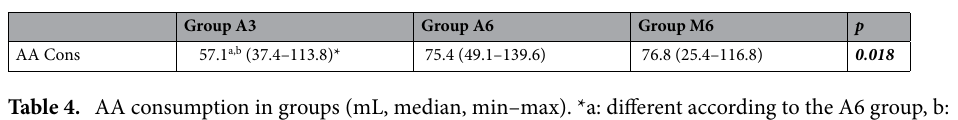
Table 4. AA consumption in groups (mL, median, min–max). *a: different according to the A6 group, b: different according to the M6 group. Statistically significant “p” values are in bold and